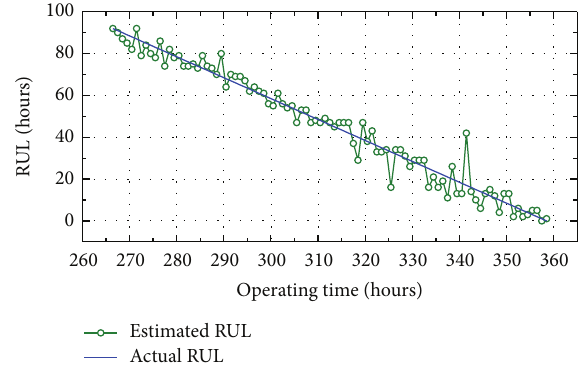
Figure 16: RUL estimation for the ball-fault case based on PSS.